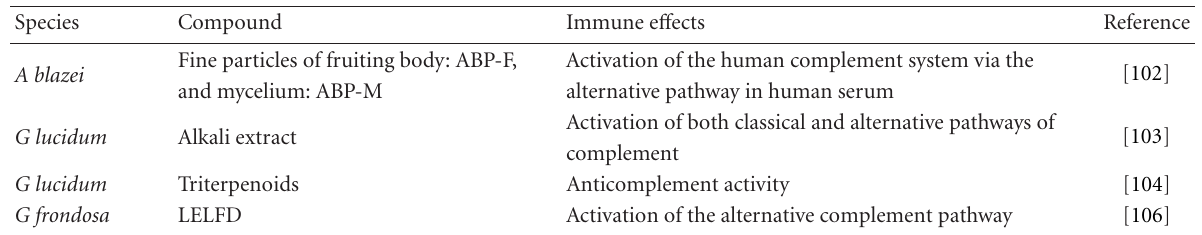
Table 5. Immunomodulatory activities of mushroom compounds on